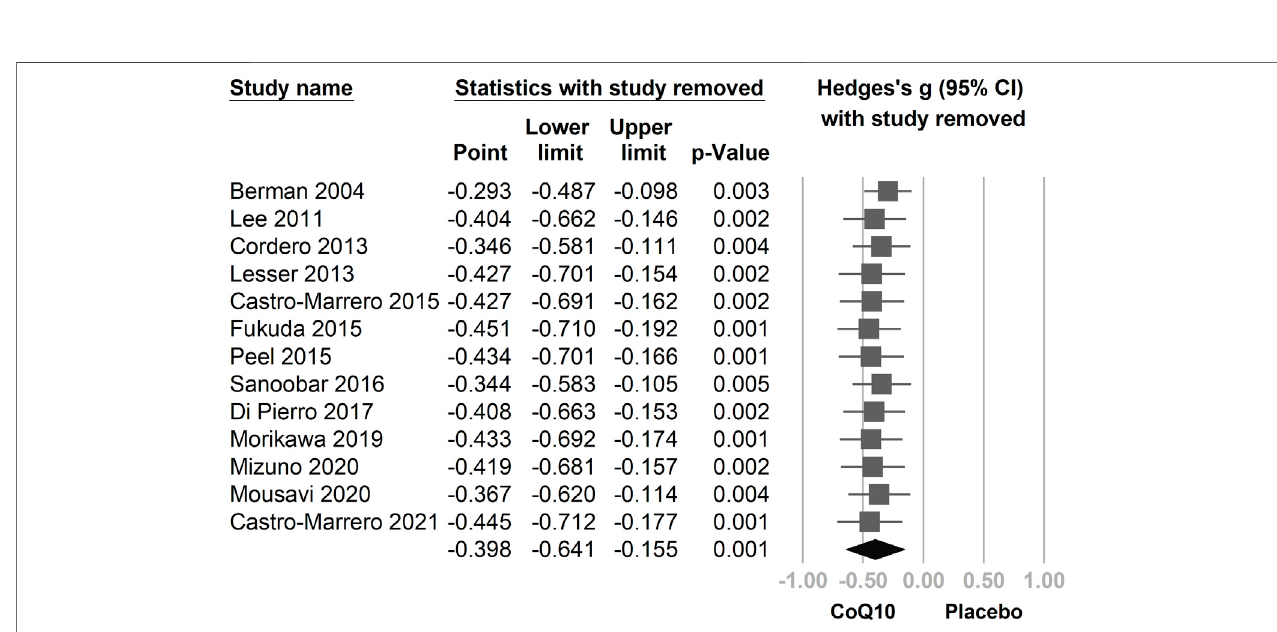
FIGURE 4 | The results of a sensitivity analysis using the one-study removal method. The main result did not change signi fi cantly after removing any one of the included trials. All analyses showed statistically signi fi cant effects of CoQ10 in relieving fatigue. CI, con fi dence interval.